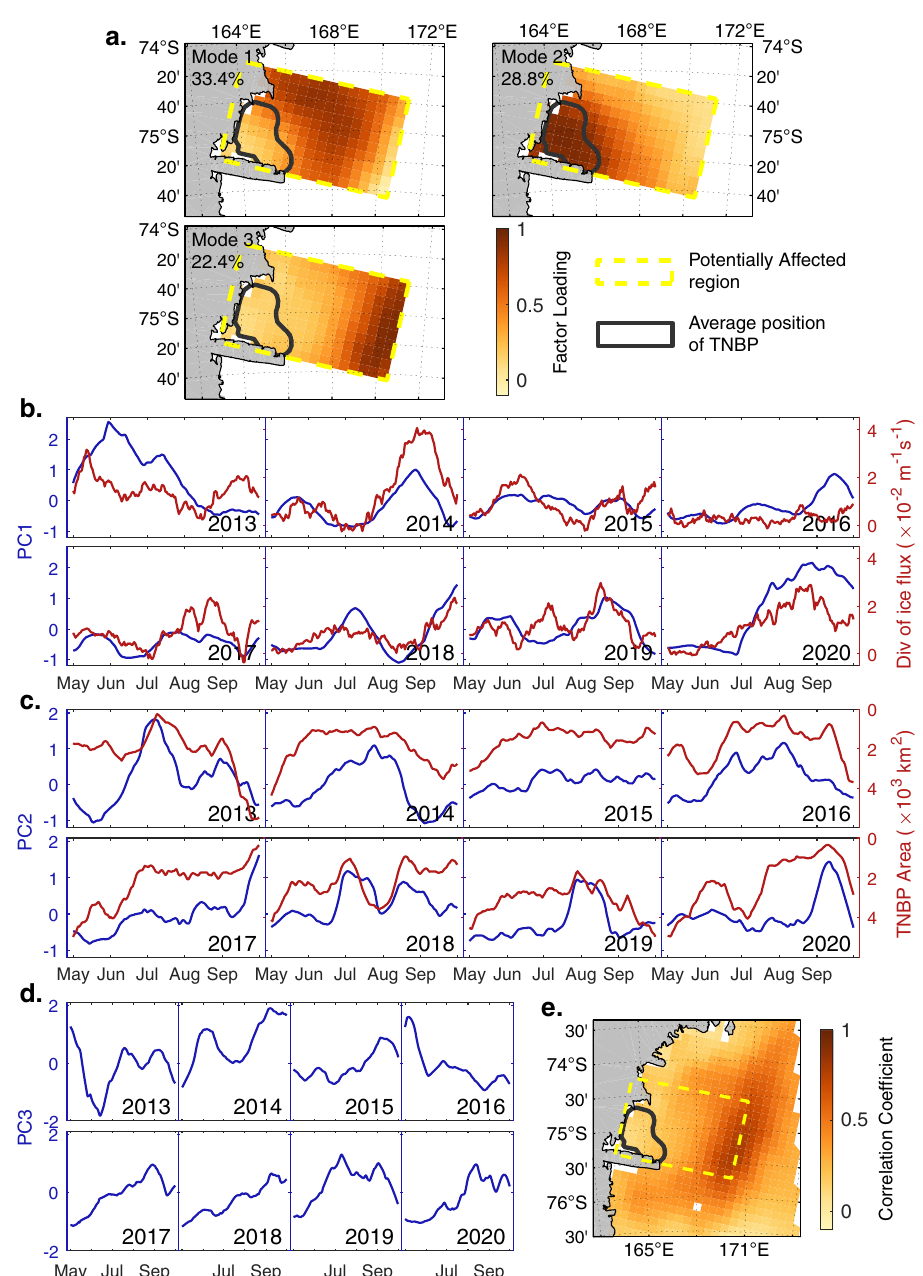
Fig. 8 The factor analysis for sea ice volume in the potentially affected region. a Factor loadings and variance (contributes to each mode 1-3). b Principal component 1 (PC1, blue line) and sea ice fl ux divergence (calculated in the region where the factor loading of mode 1 is larger than 0.5, red line). c Principal component 2 (PC2, blue line) and area of the TNBP (red line). d Principal component 3 (PC3). e Correlation coef fi cient between sea ice thickness and PC3. The yellow box in ( a ) and ( e ) is the potentially affected region, and the grey line shows the mean position of the TNBP. A 30-day window smooth is done for ( b – d